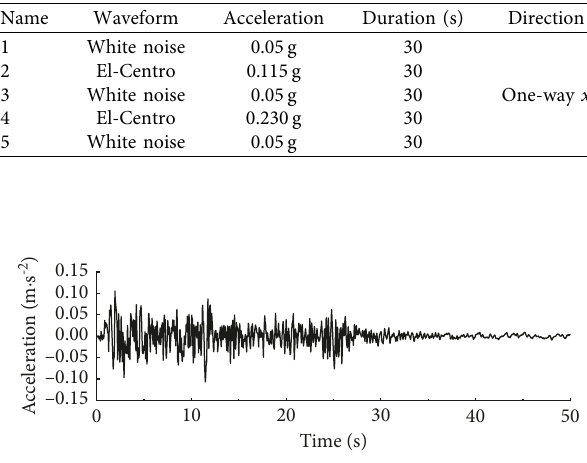
Figure 8: Stratum accelerometers Table 7: Shaking-table test loading scheme.